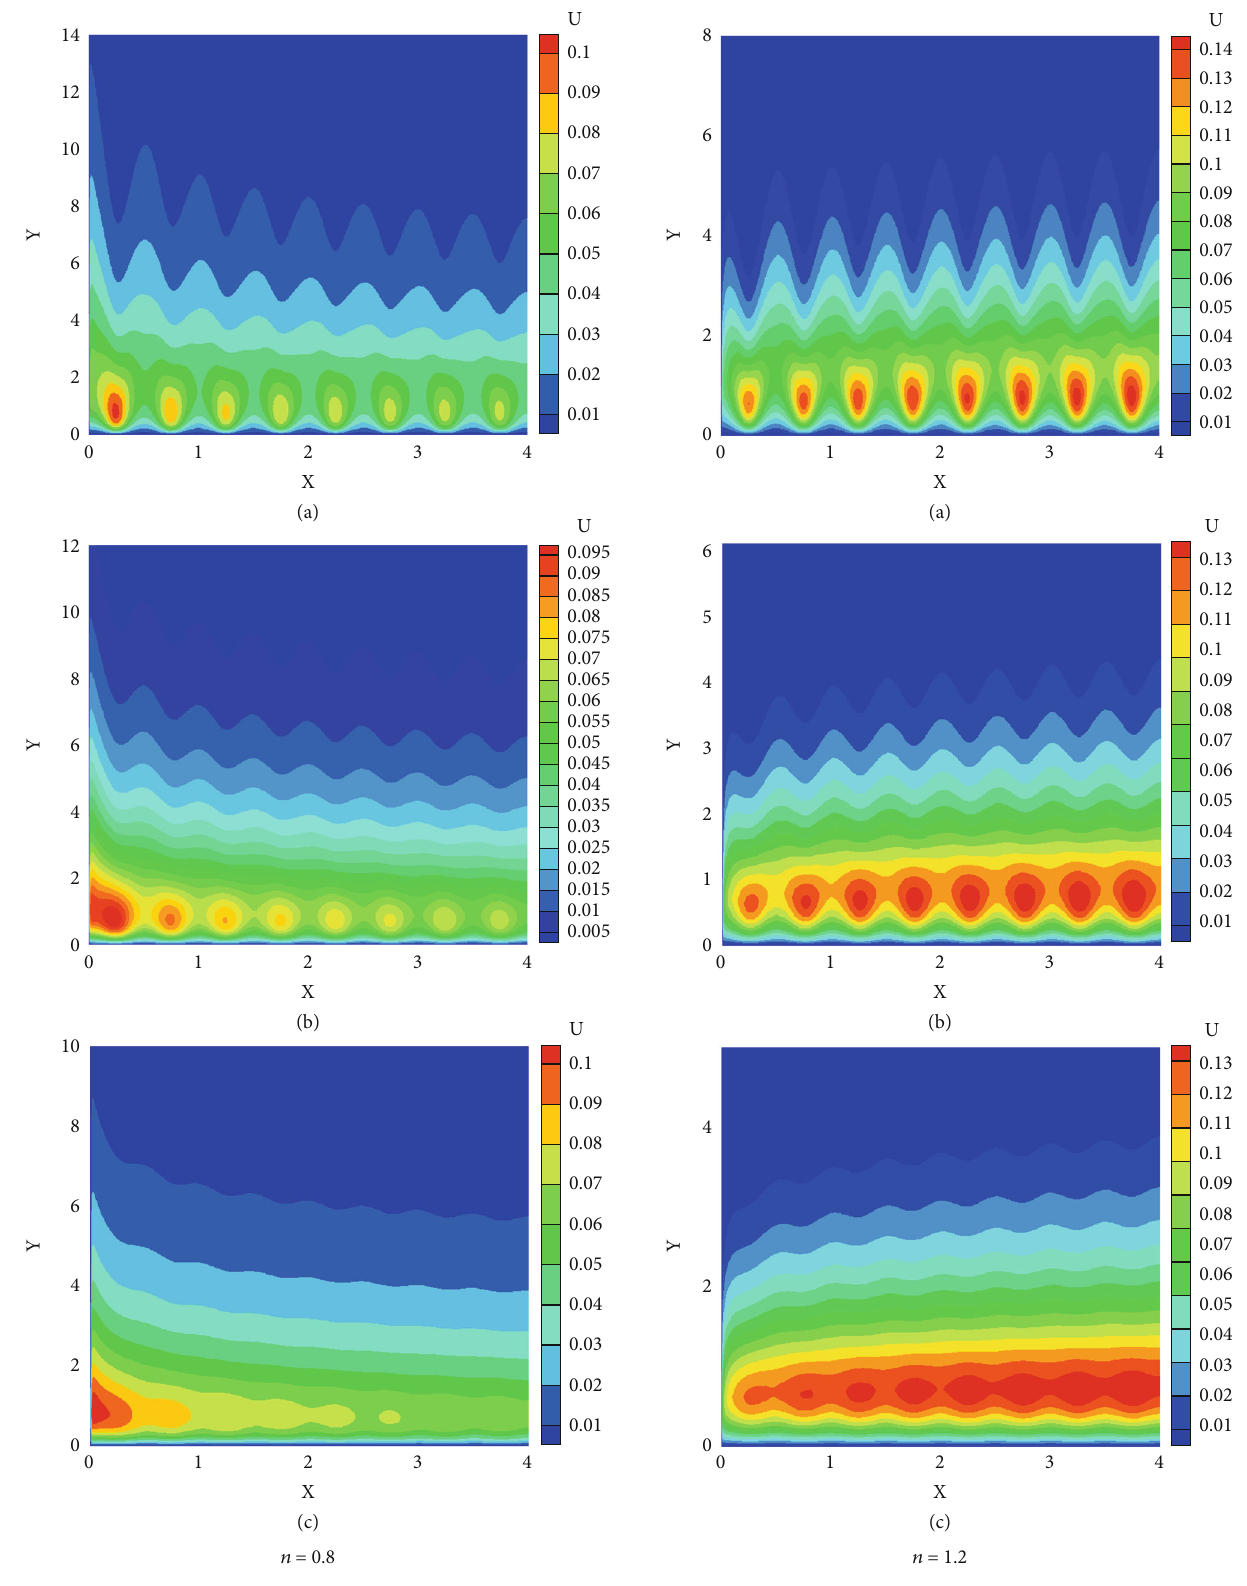
Figure 13: Velocity contour for Pr = 10 , Br = 0 : 5 , n = 0 : 8 , Q = − 0 : 05 , α = 0 : 2 (a), α = 0 : 1 (b), and α = 0 : 05 g